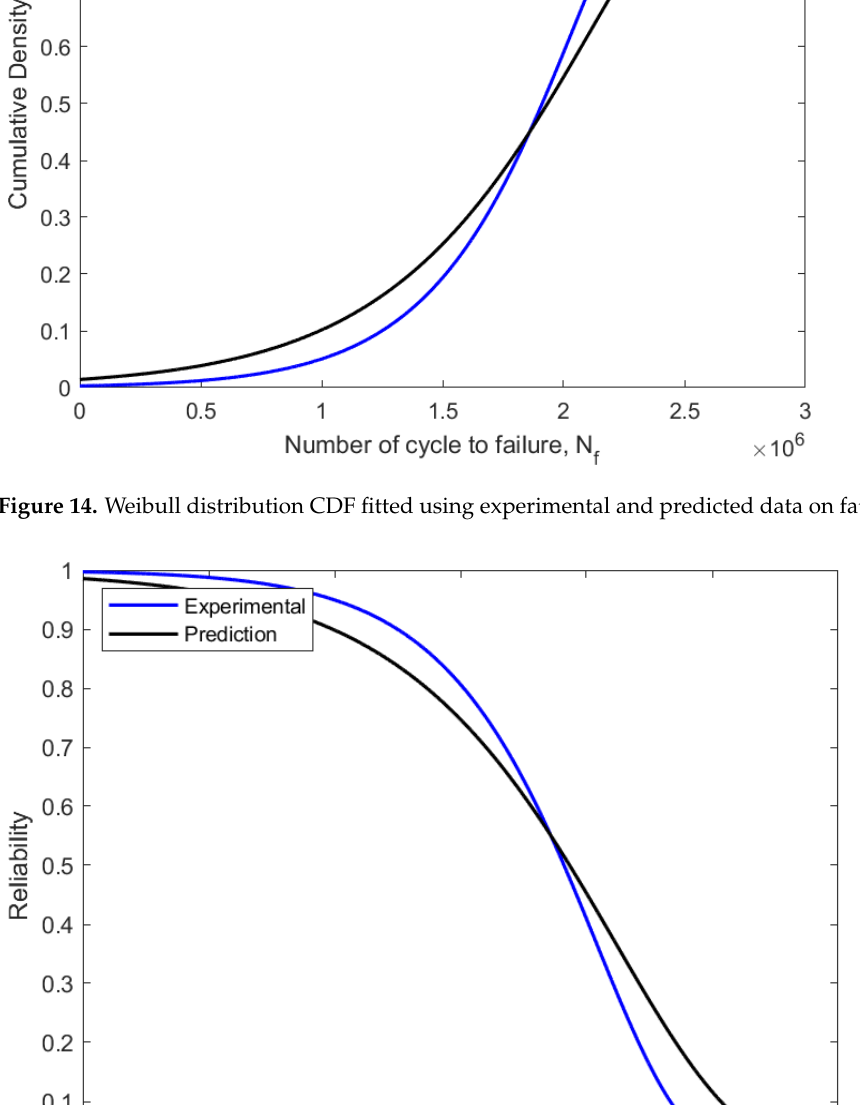
Table 7. MCTF of fatigue data obtained by experiment and prediction.